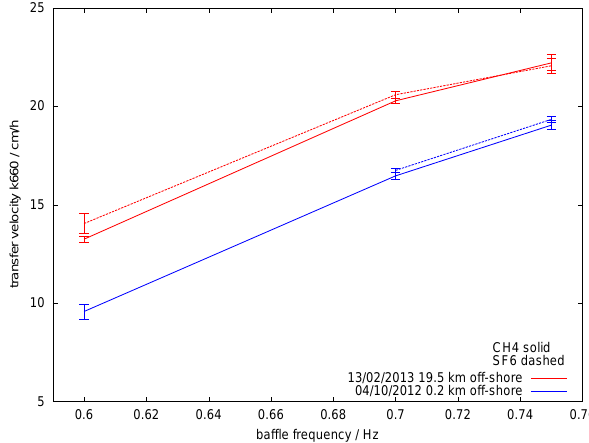
Figure 11. Estimated transfer velocities k w vs. baffle frequency for the most landwards station of the autumn transect (low k w ) and the most off-shore station from the winter transect (high k w ) for CH 4 and SF 6 . Note that for the 4 October 2012 transect, the datum for SF 6 at F = 0 . 6Hz is excluded due to chromatography problems for this particular